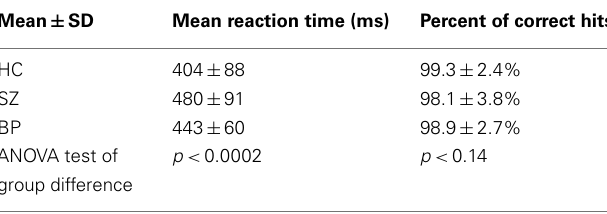
Table 1 |Auditory oddball behavioral results: mean reaction time and percent correct hits are presented for each group.